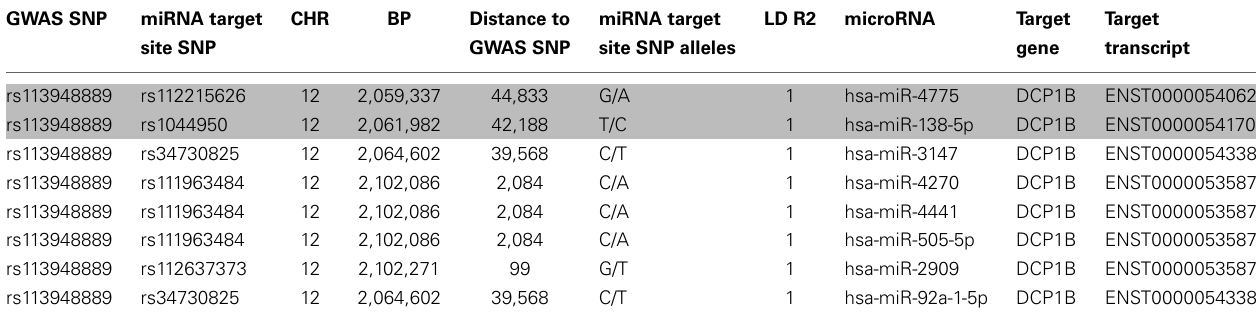
Table 1 | SNPs in LD with memory-associated SNP rs113948889 and predicted to affect miRNA-to-mRNA binding in silico . GWAS SNP miRNA target